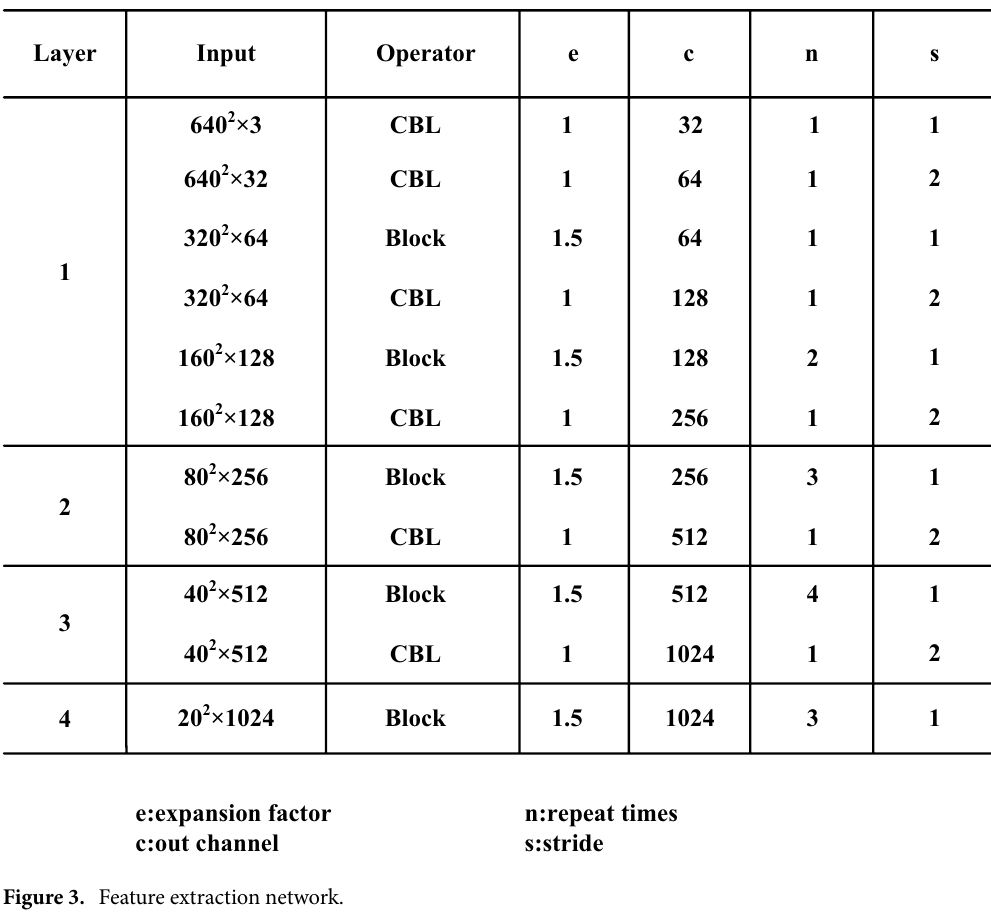
Figure 3. Feature extraction